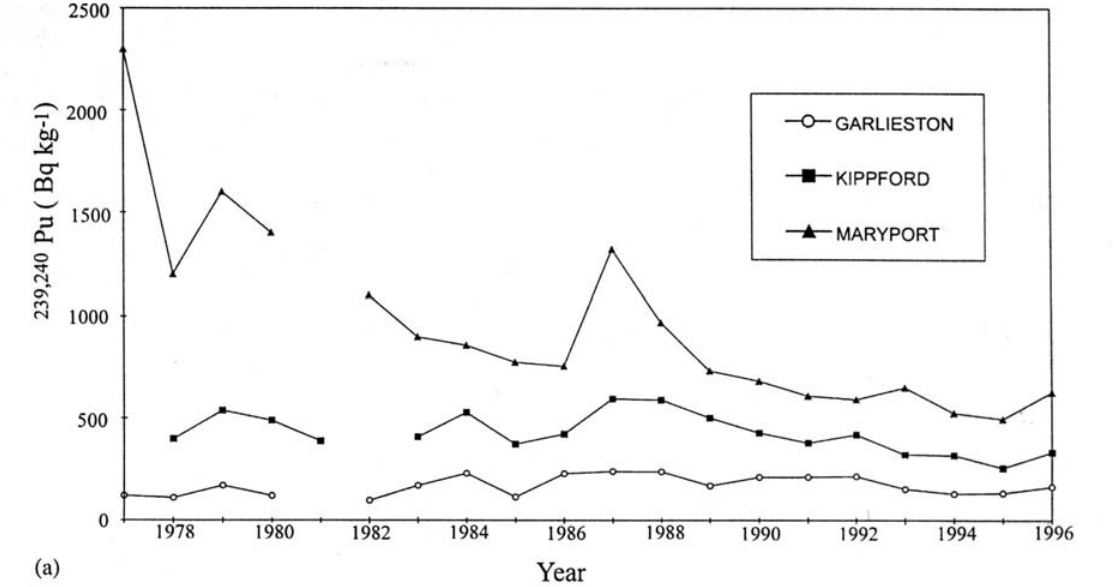
FIGURE 9. 239,240 Pu concentrations (Bq/kg dry) in surface intertidal sediments at Maryport, Kippford, and Garlieston, at increasing distance from Sellafield, 1977–1996[34].